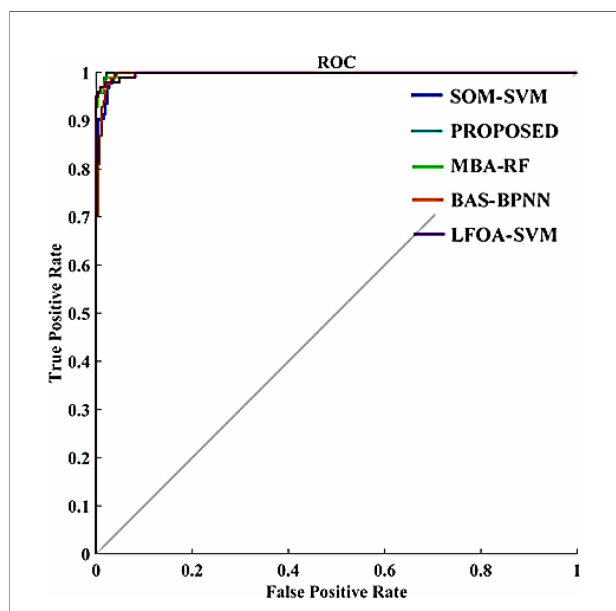
FIGURE 13 | ROC curve